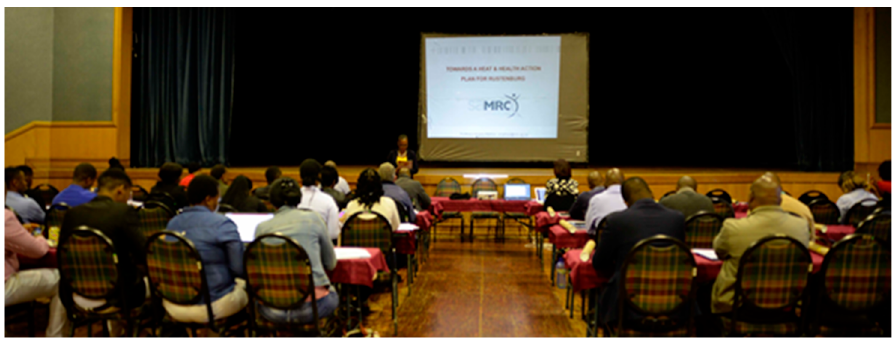
Figure 3. An RLM member of the mayoral committee opens the stakeholder workshop in Rustenburg with a brief address about the importance of this project (Permission obtained from participants to take the photograph at the